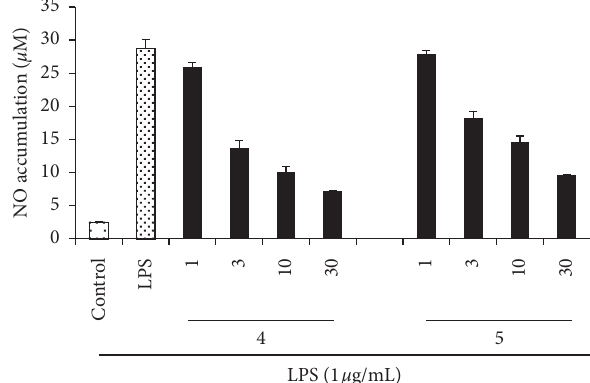
Figure 3: Inhibitory effect of compounds 4 and 5 on the LPS- induced NO production in RAW 264.7 cells. RAW 264.7 cells were pretreated with different concentrations (1, 3, 10, and 30 μ M) of the tested compounds for 1h and then with LPS (1 μ g/mL) and in- cubated for 24 h. Control values were obtained in the absence of LPS and compounds. The data are expressed as the mean ± SD ( n � 3). Statistical significance was assessed by two-tailed unpaired Student’s t -test, and P < 0 . 05 was considered statistically